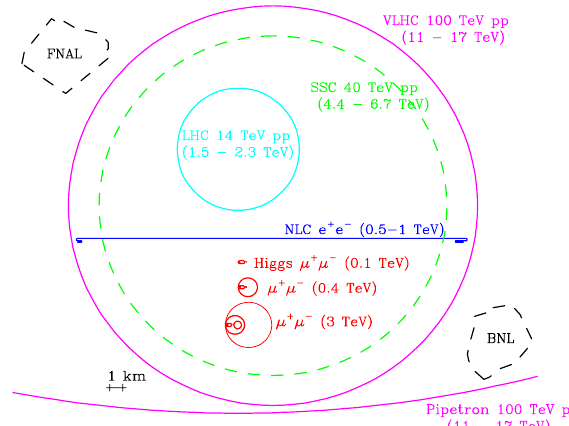
FIG. 1. (Color) Comparative sizes of various proposed high energy colliders compared with the FNAL and BNL sites. The energies in parentheses give for lepton colliders their COM energies and for hadron colliders the approximate range of COM energies attainable for hard parton-parton